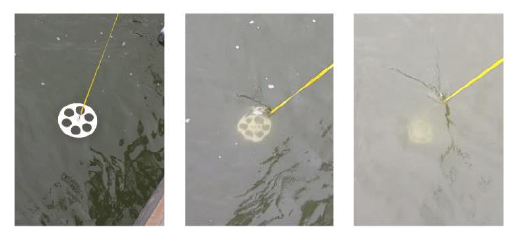
Figure 8: Estimation of visibility depth by lowering a Secchi- disk into the water body